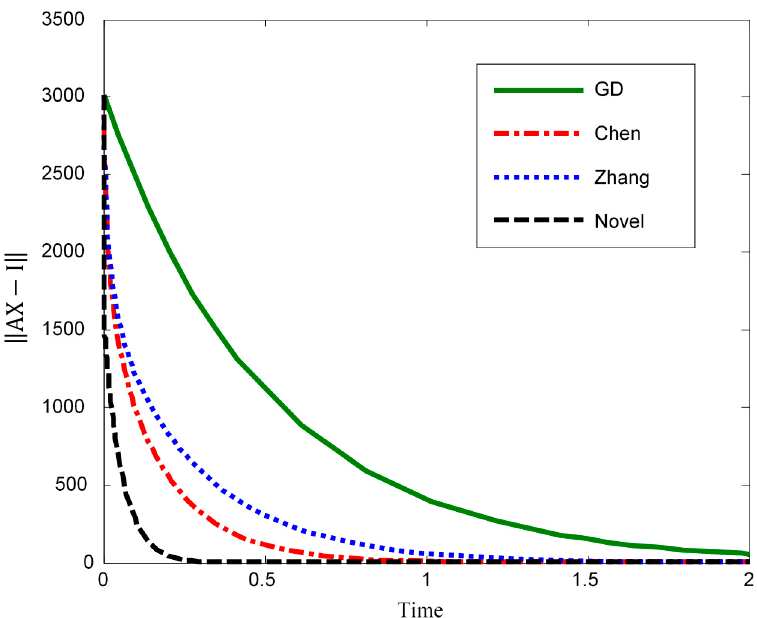
Figure 7. Comparison of different DNN models with respect to convergence speed under the same conditions—benchmarking. In this figure, GD refers to the “gradient descent” method. Our novel method (see novel in the figure; Equation (24)) is calculated for n = 3. The fast convergence of our method to the exact solution is clearly demonstrated. It is also clear that this convergence would be much faster if higher values of n are taken (n > 3).